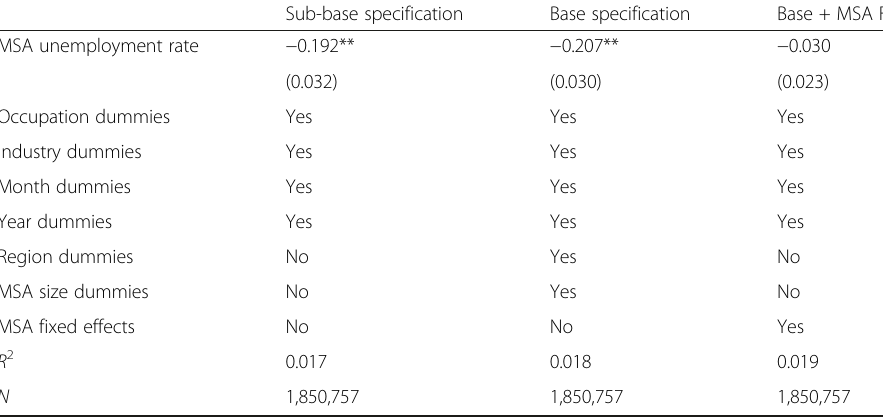
Table 2 Unemployment effects on multiple job